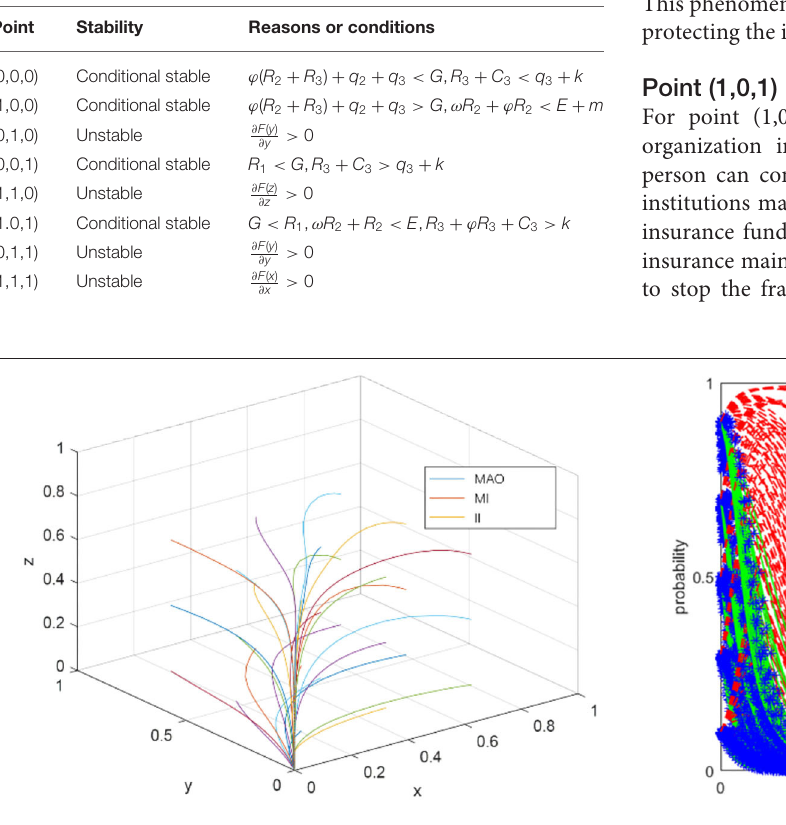
TABLE 3 | Equilibrium points and their asymptotic stability.